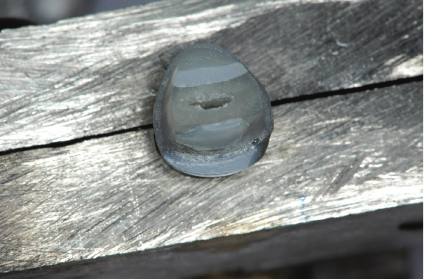
Figure 2: Coronal preparation for full coverage crown in both